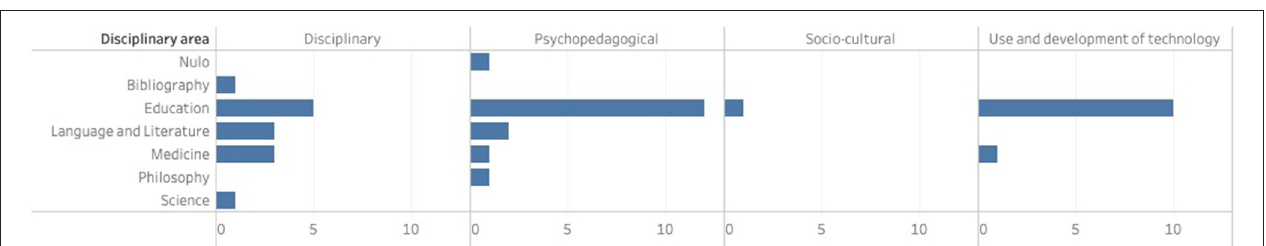
FIGURE 1 | Quality criteria for papers selection for SLR.